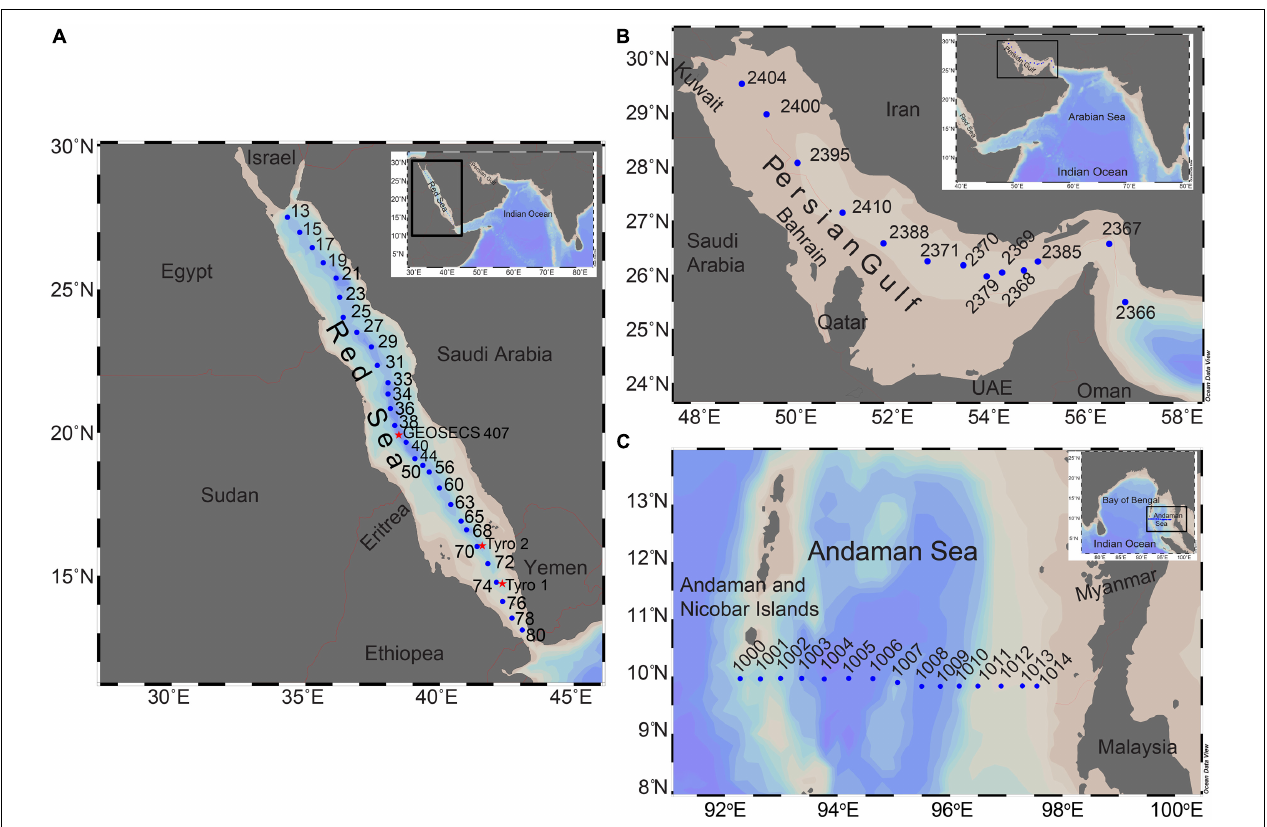
FIGURE 1 | The marginal seas of the Indian Ocean and locations of stations constituting vertical sections presented in Figures 2 , 4 , 5 : (A) Red Sea, R.V. Sagar Kanya cruise in May 1983 (black symbols); (B) Persian Gulf, R.V. Atlantis II cruise in February 1977; and (C) Andaman Sea, R.V. Knorr cruise in October 1995. The red symbols in (A) denote locations of GEOSECS Station 407 and the two Tyro stations data from which are compared with Sagar Kanya data in Figure 3 .